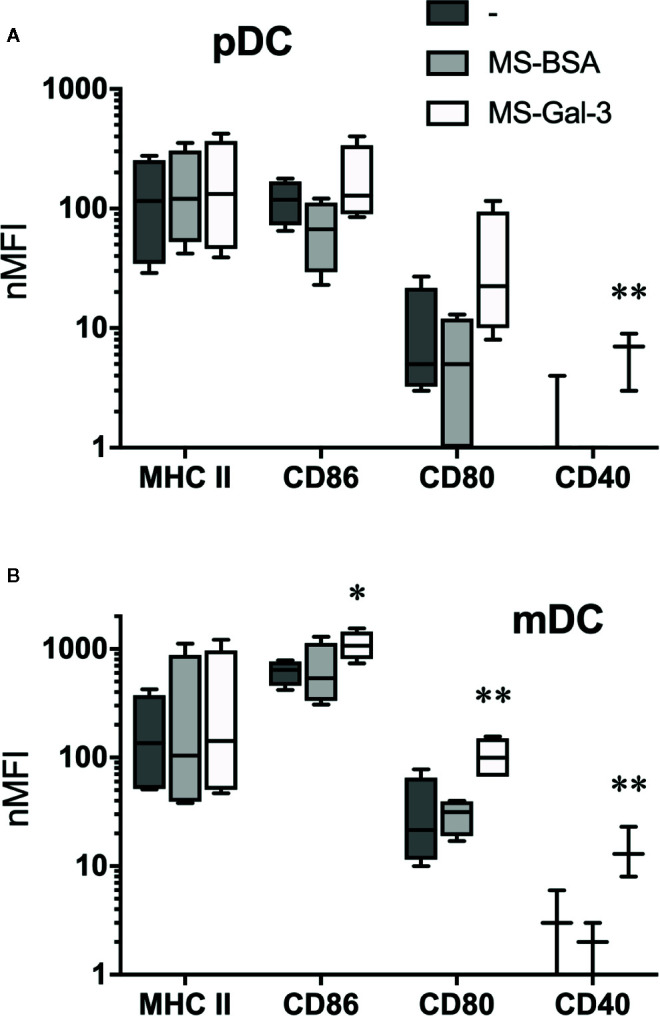
Gal-3-dependent induction of dendritic cell (DC) activation markers. (A) Plasmacytoid DC (pDC) and (B) myeloid DC (mDC) were co-cultured with MS-Gal-3, MS-BSA, or medium alone. After 20 h incubation, cells were analyzed by flow cytometry for expression of the indicated markers. Shown are Box-Whisker plots, n = 3-4. **P < 0.02 and *P < 0.05 vs. medium alone.